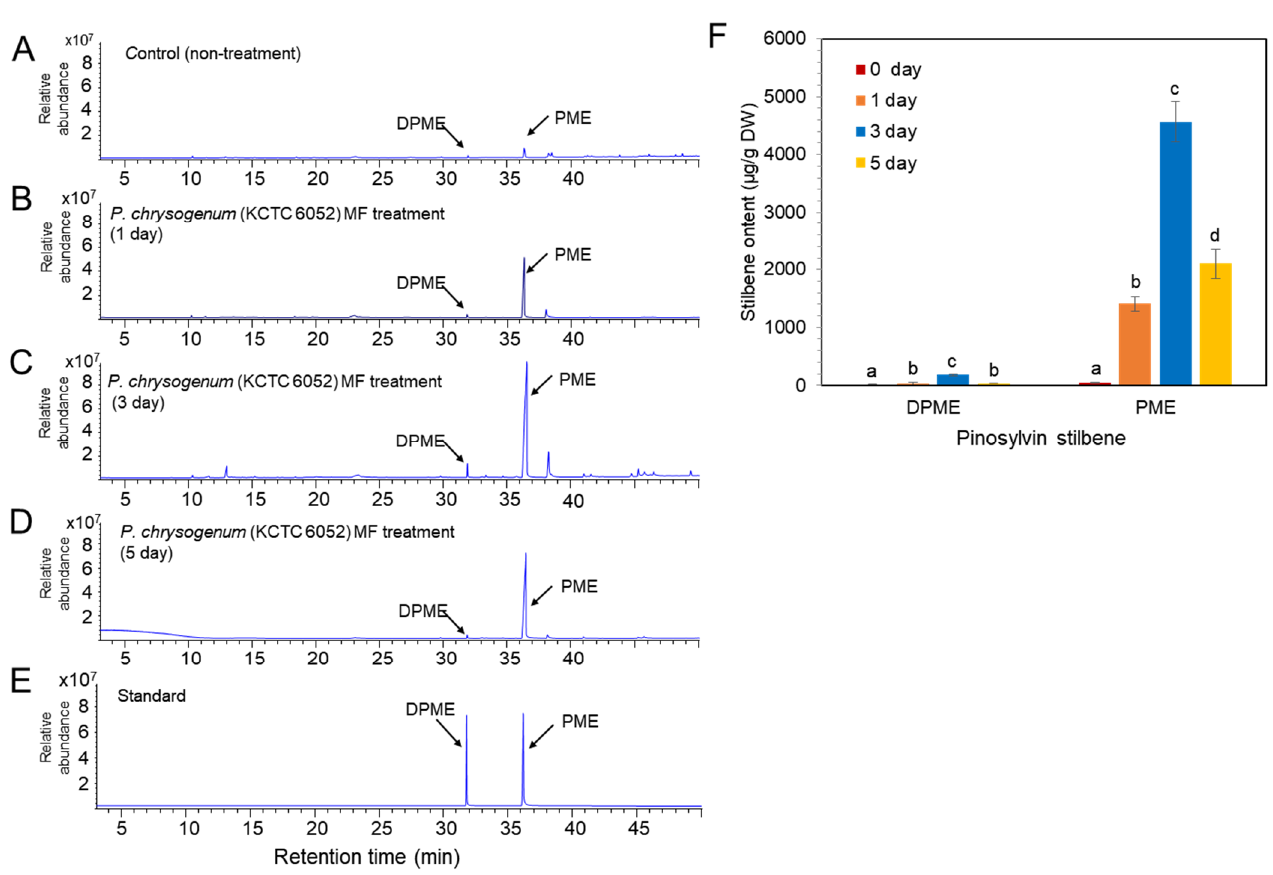
Figure 6. GC/MS analysis of DPME and PME amounts in cultured cells of P. koraiensis by fungal elicitor ( P. chrysogenus CE) treatment. ( A ) GC chromatogram of cell extracts from the control without MF treatment. ( B – D ) GC chromatogram of cell extracts after 1 day ( B ), 3 days ( C ), and 5 days ( D ) of MF treatment. ( E ) GC chromatogram of authentic standards of DPME and PME. ( F ) Content of DPME and PME in cultured cells during 5 days of culture after CE treatment. Different letters above the bars indicate significantly different values ( p < 0.05), calculated using one-way ANOVA followed by Duncan's post hoc analysis .